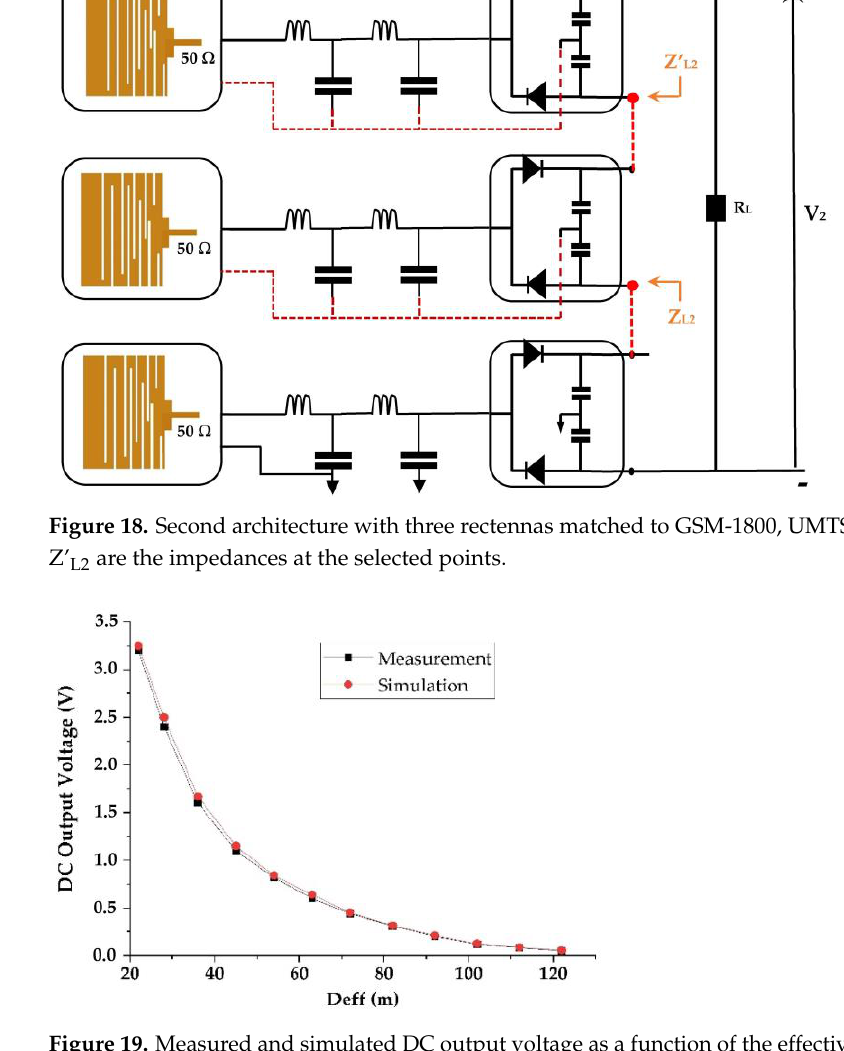
Figure 19. Measured and simulated DC output voltage as a function of the effective distance for 2 k Ω resistance load.